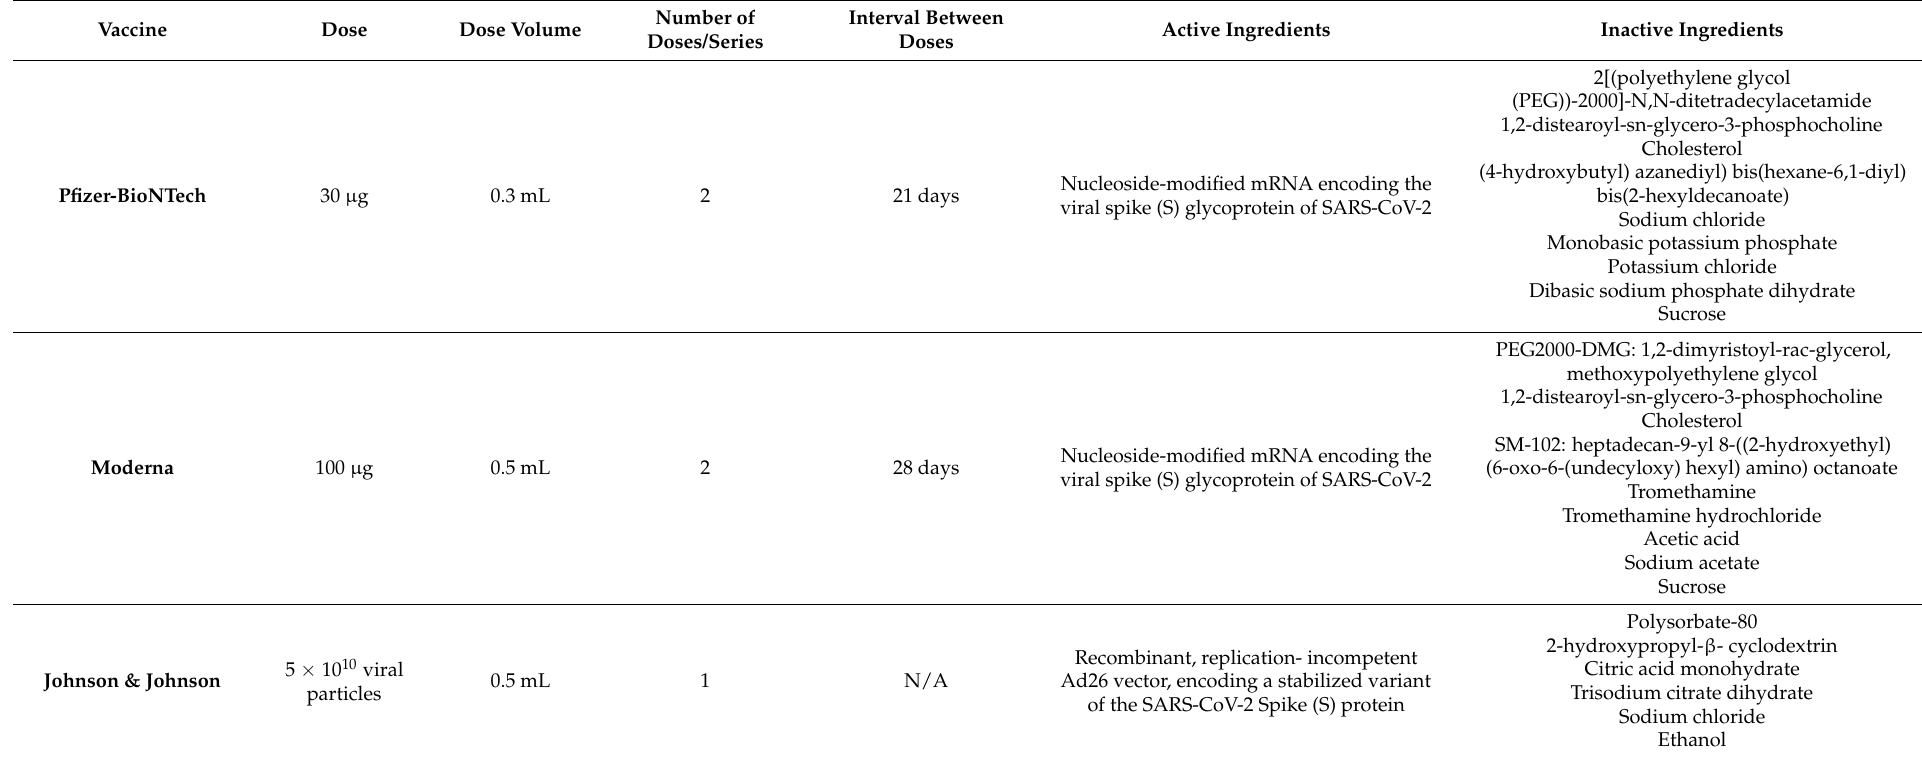
Table 2. Dosing, schedule and ingredients of COVID-19 Vaccines Authorized for Emergency Use